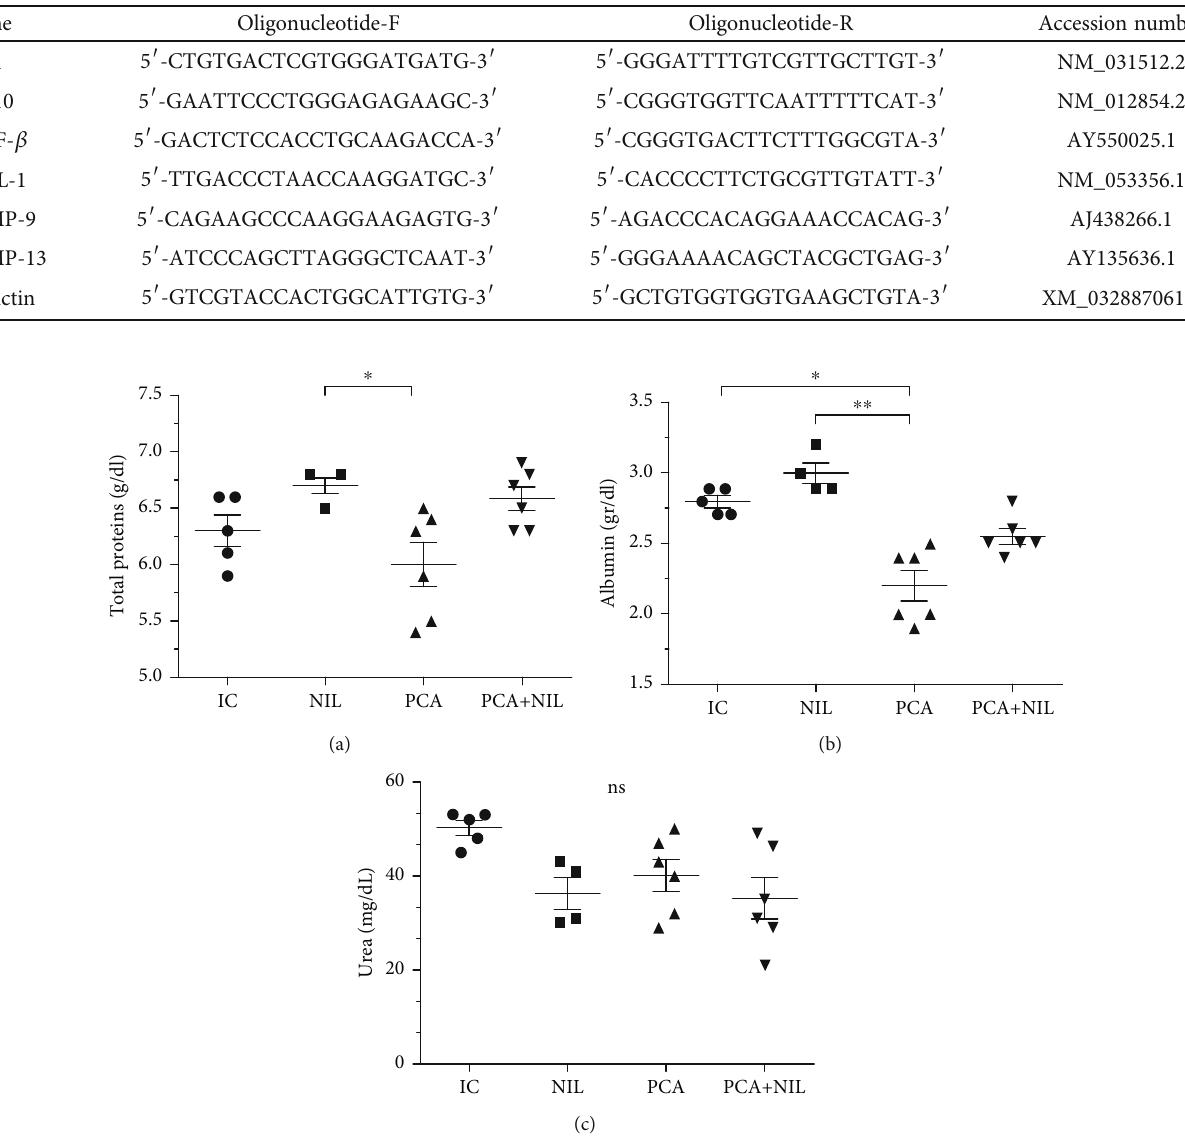
Table 1: Oligonucleotide sequences.